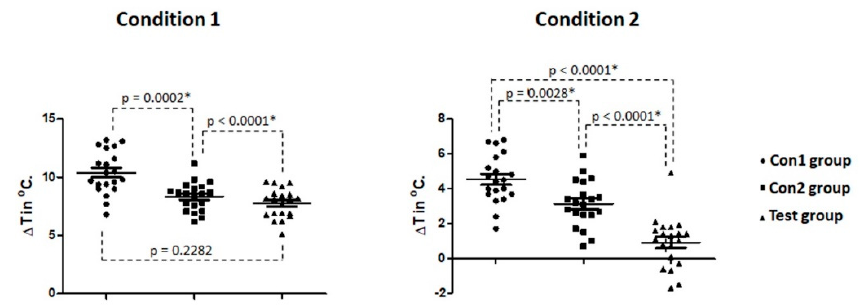
Figure 5. Points graph of the calculated temperature variation ( ∆ T) between the initial temperature and